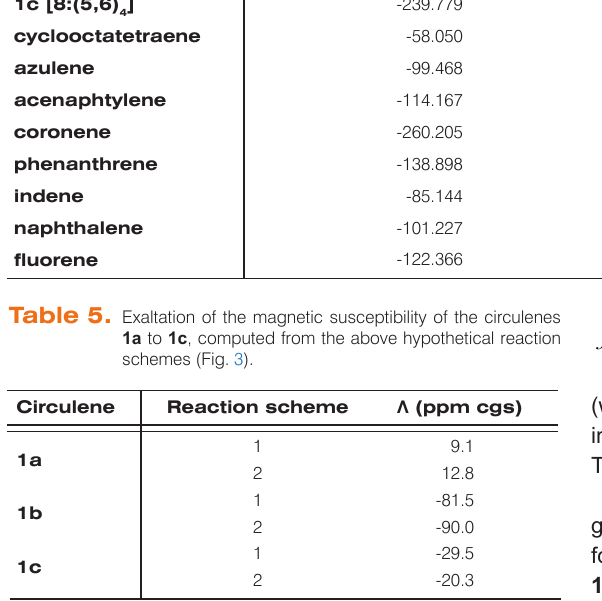
The results in Table 7 are in good agreement with the geometric, magnetic and energetic criteria above used for the evaluation of aromaticity in the three circulenes 1a to 1c . The highest value of the absolute hardness, a